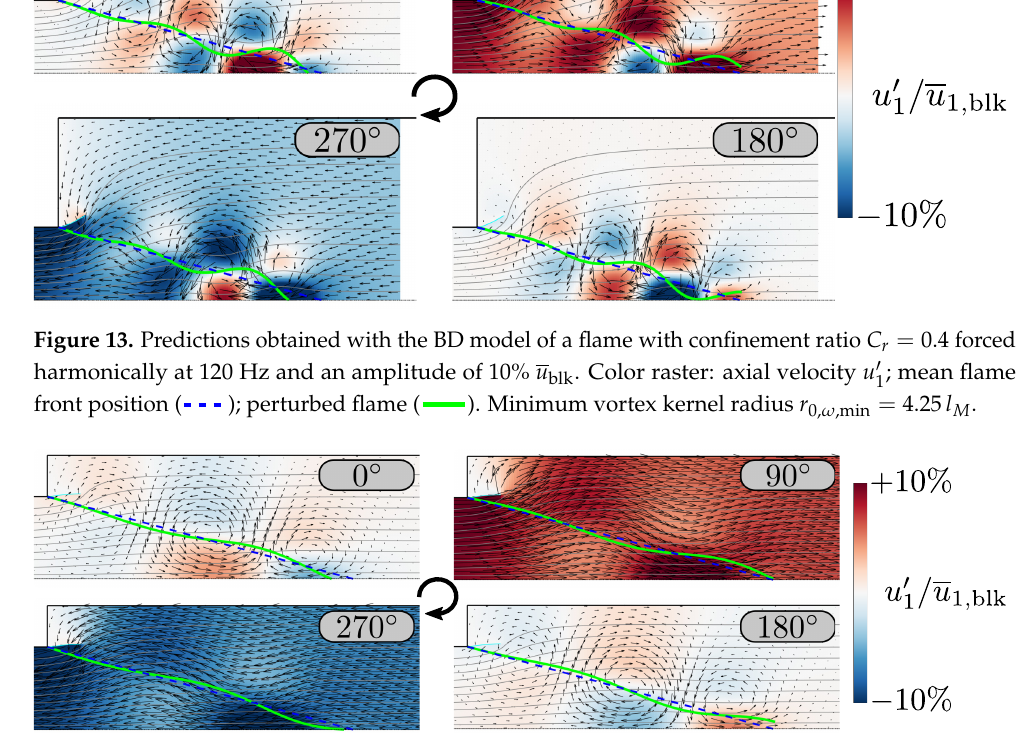
Figure 14. Results of a simulation as described in Figure 13, but for confinement ratio C r =